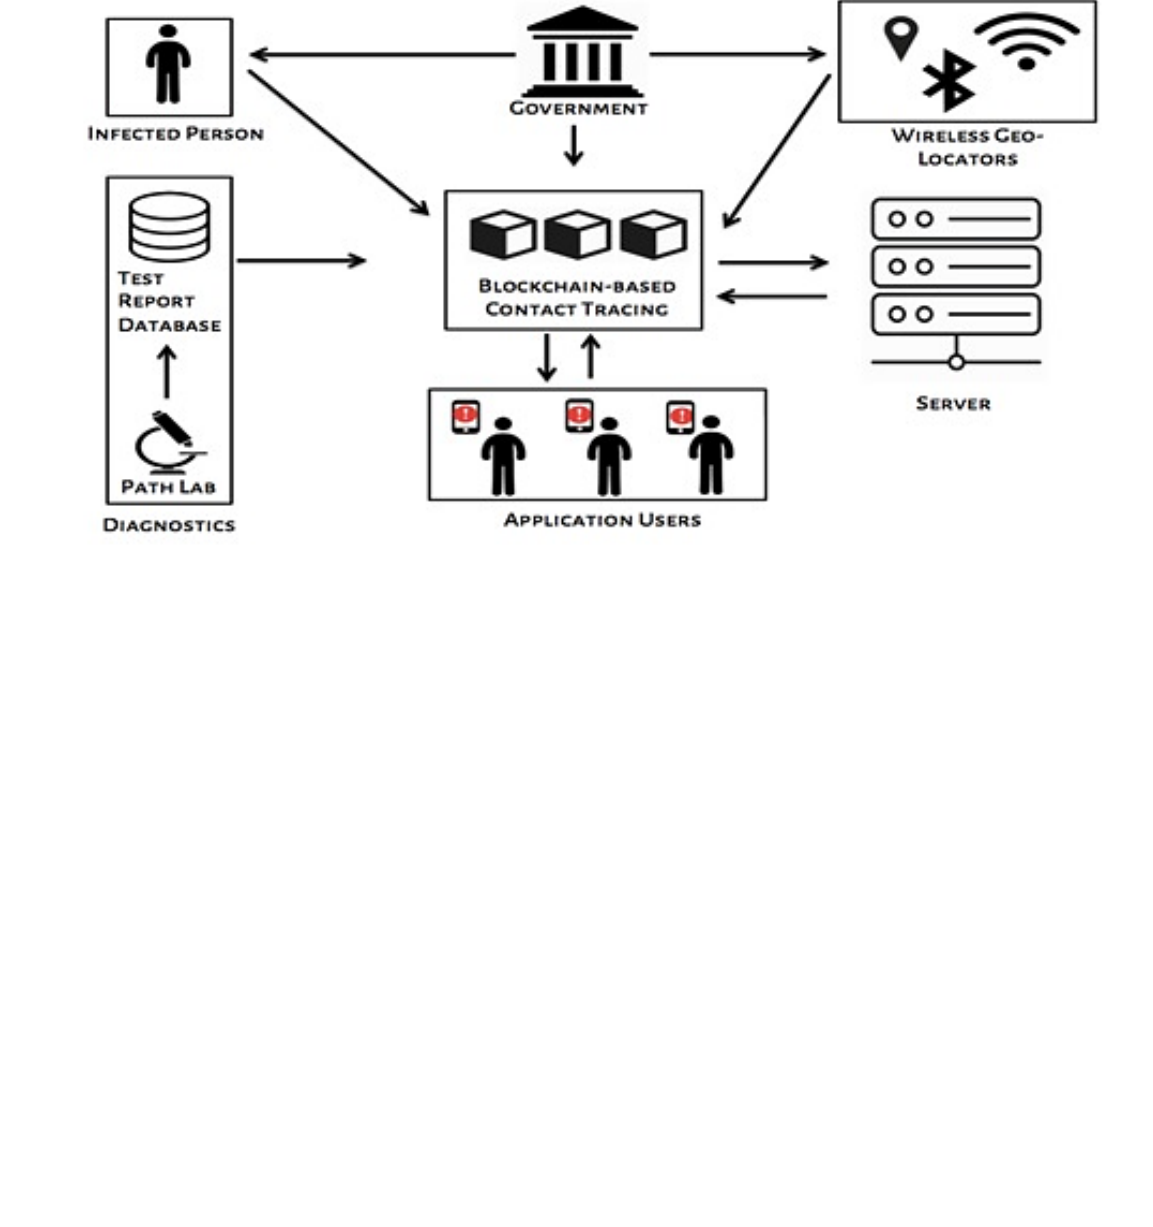
Figure 4. Blockchain-based contact tracing app